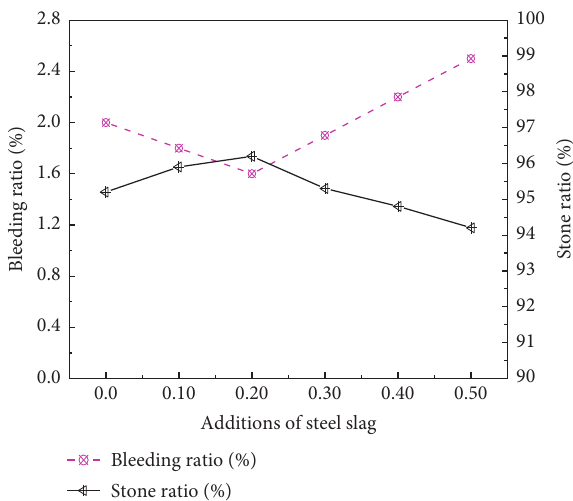
Figure 8: The bleeding ratio and stone ratio of the waste sediment- based grouting material with different addition amounts of steel